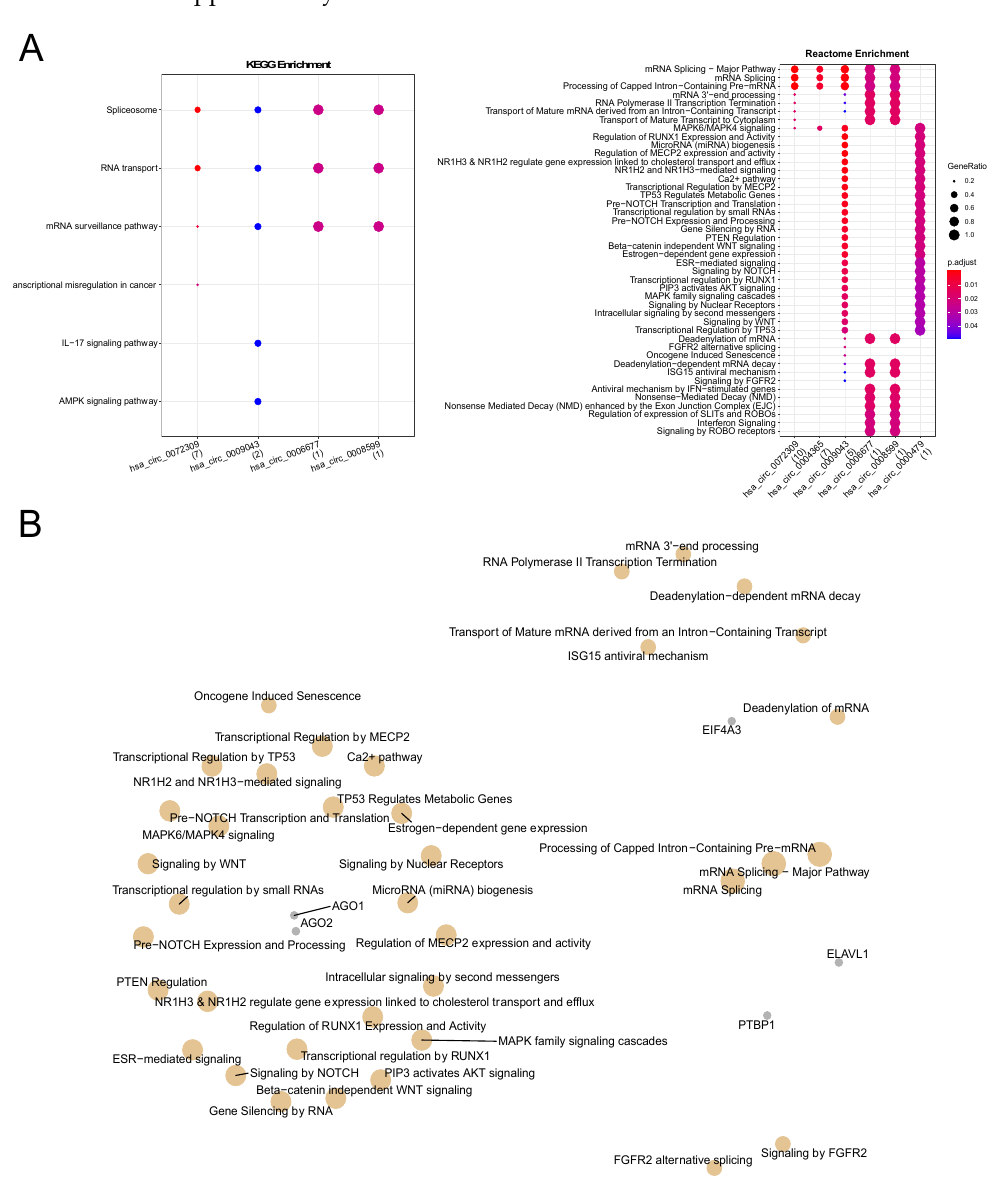
Figure 3. Functional enrichment analysis of the RNA binding proteins (RBPs) bound to hsa_circ_0072309, circ_0004365, circ_0006677, circ_0008599, circ_0009043, and circ_0000479. ( A ) Kyoto Encyclopedia of Genes and Genomes (KEGG) and Reactome enrichments (left and right panels, respectively) for each circRNA that had statistically significant results; ( B ) Gene-Concept network of the Reactome enrichment result showing that AGO1/2, EIF4A3, ELAVL1, and PTBP1 were the main RBPs that enriched in cancer-related pathways.